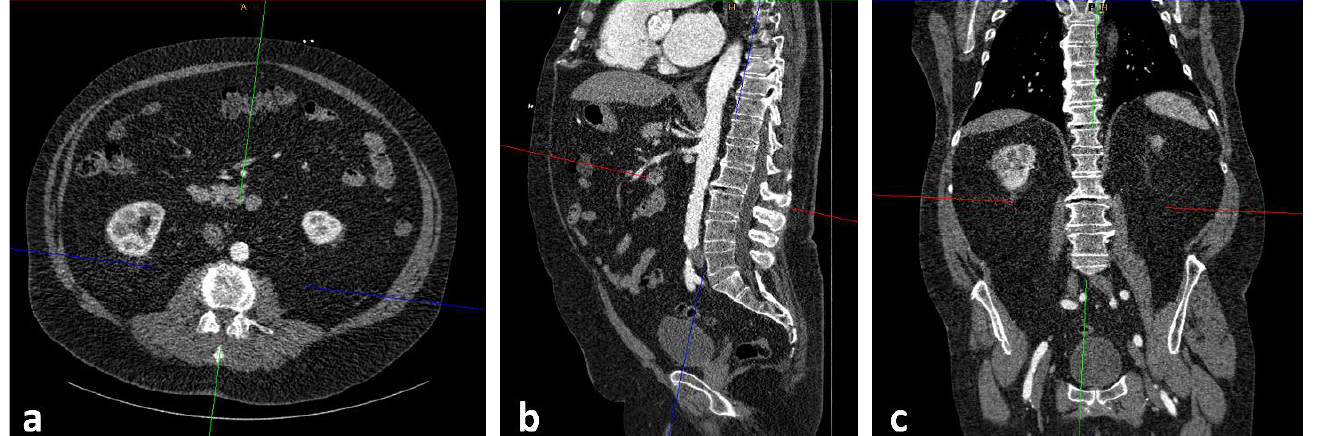
Figure 1. Process of slice selection using the Extended Multiplanar Reconstruction Plugin in IMPAX. The axial slice ( a ) was aligned parallel to the superior endplate of the third lumbar vertebrae at sagittal ( b ) and coronal ( c ) reconstructions.